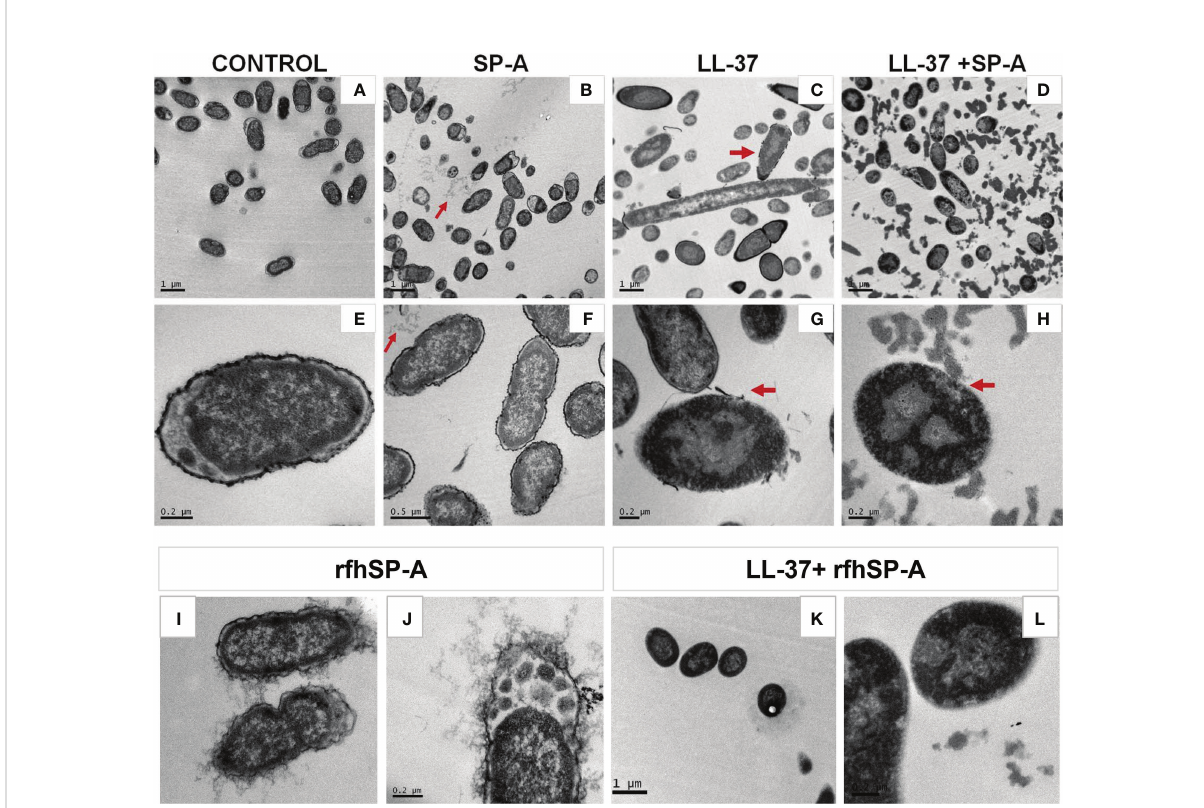
FIGURE 8 Effect of LL-37 and/or SP-A or rfhSP-A on the ultrastructure and morphology of K. pneumoniae K2. Untreated bacteria (A, E) , and bacteria treated with SP-A (0.3 µM) (B, F) , LL-37 (55.5 µM) (C, G) , LL-37+SP-A (D, H) , rfhSP-A (1.5 m M) (I, J) , and LL-37+rfhSP-A (K, L) for 30 min at 37°C are shown. Red arrows in B and F show self-aggregates of SP-A that do not interact with bacteria, while red arrows in (C, G) indicates disruption of the capsule and bacterial outer membrane by LL-37. Red arrows in (D, H) suggest the formation of protein-induced aggregates of outer membrane fragments. Representative micrographs of two independent experiments are